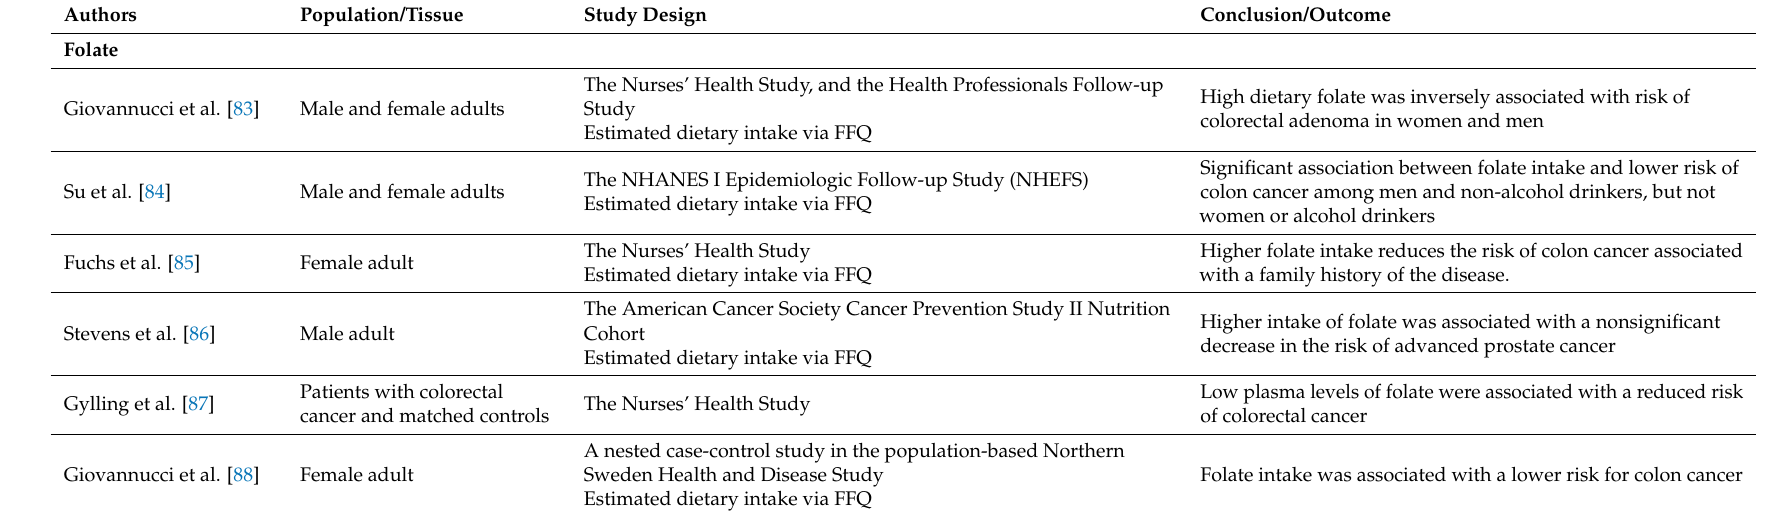
Table 2. Clinical studies of the impact of methyl donor micronutrients on